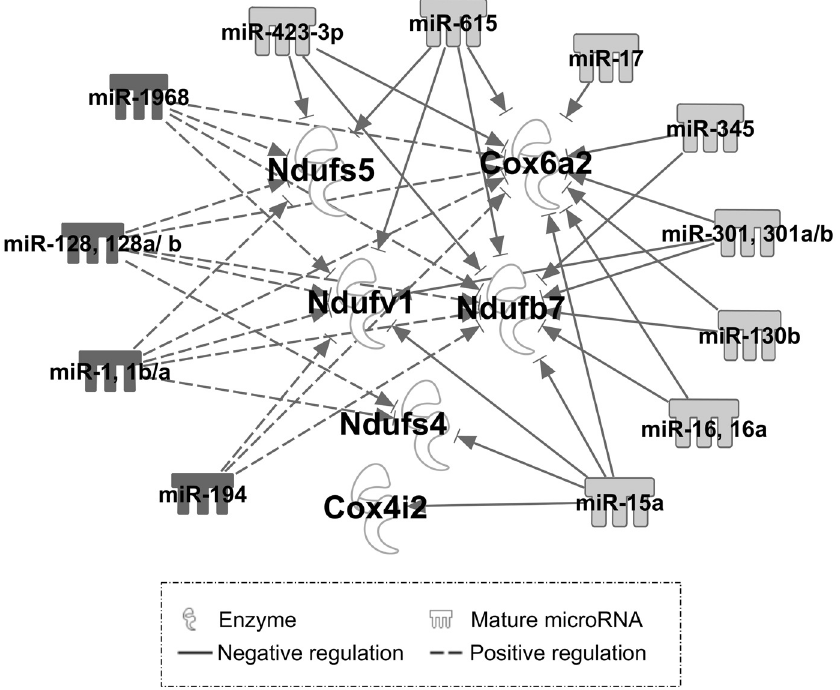
Fig 6. A regulatory network of differentially-expressed miRNAs and genes in C2C12 myogenesis, focusing on mitochondrial energy-metabolism pathways. Pearson correlation coefficient analysis identified a number of miRNAs-mRNA correlation interactions. Only those interactions in which both miRNAs and target mRNAs significantly associated with differentiation and ATP level (FDR < 0.1) during C2C12 myotube induction were utilized to model an miRNA-regulatory network (IPA pathway designer tool). White nodes indicate mRNA target; edges indicate regulatory interaction between miRNA and target gene. Solid line label denotes negative regulation with negative correlation interaction; dashed line denotes indirect positive regulation with positive correlation